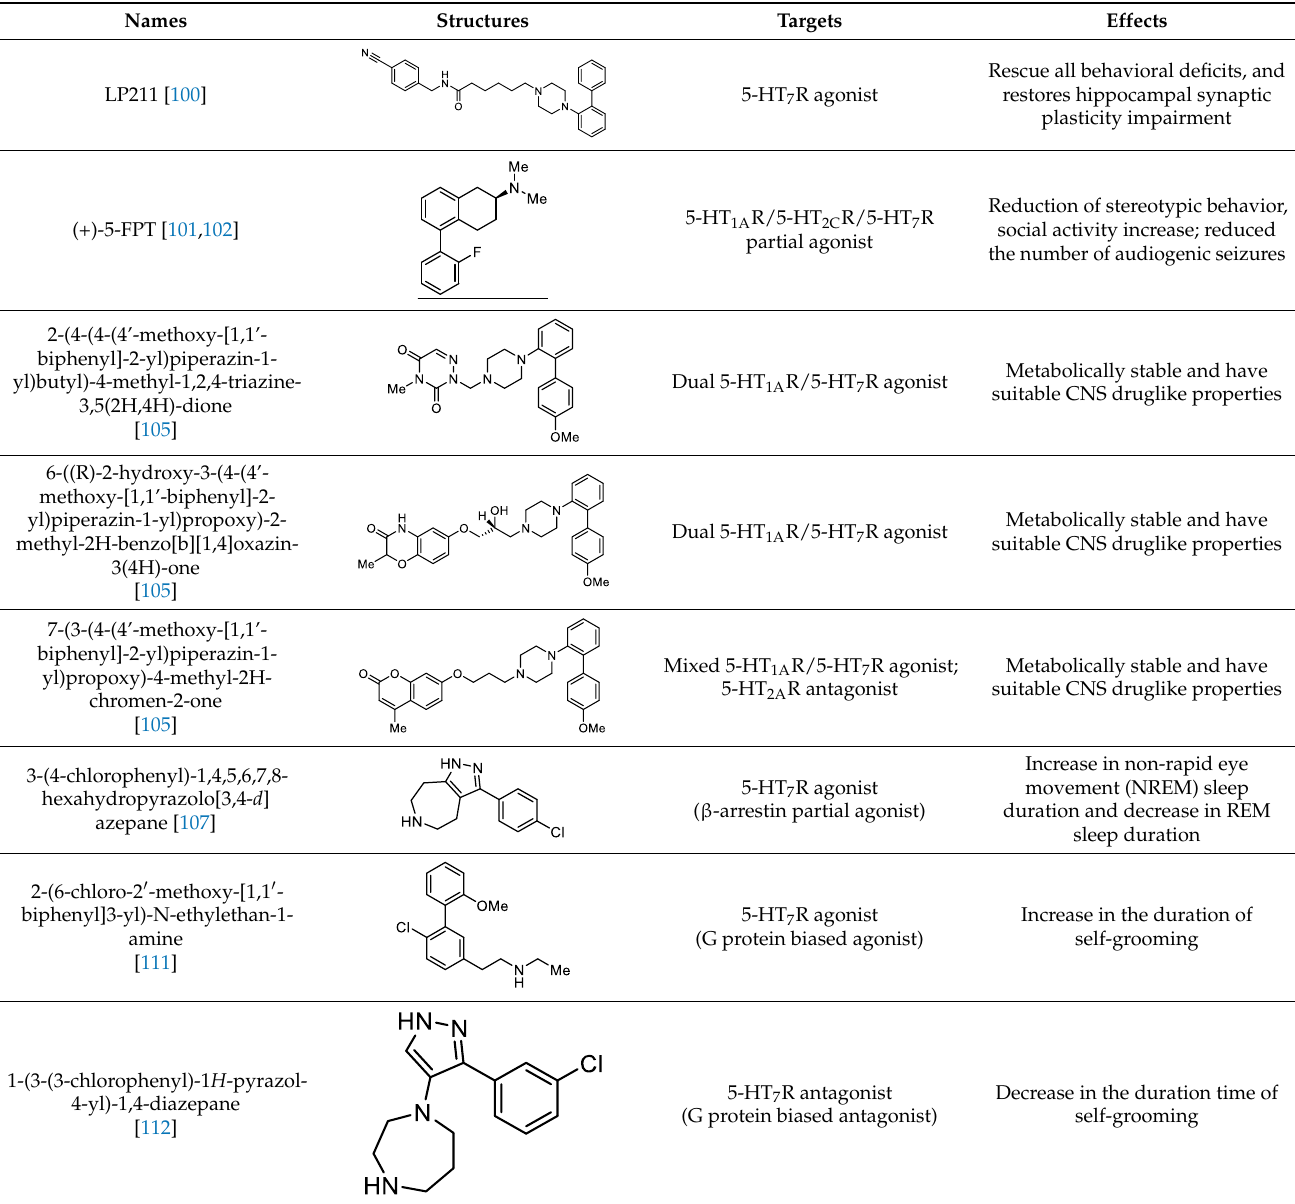
Table 4. 5-HT 7 R-targeted pharmacological agents which have potential effects on ASD treatment.